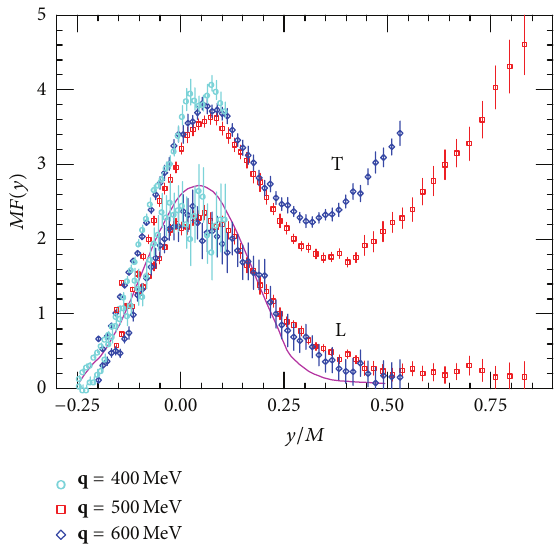
Figure 5: Longitudinal (L) and transverse (T) scaling functions of Carbon at | q | = 400, 500, and 600 MeV, resulting from the analysis of [45], based on the data of [46]. For comparison, the solid line shows the scaling function obtained from the IA using the spectral function of